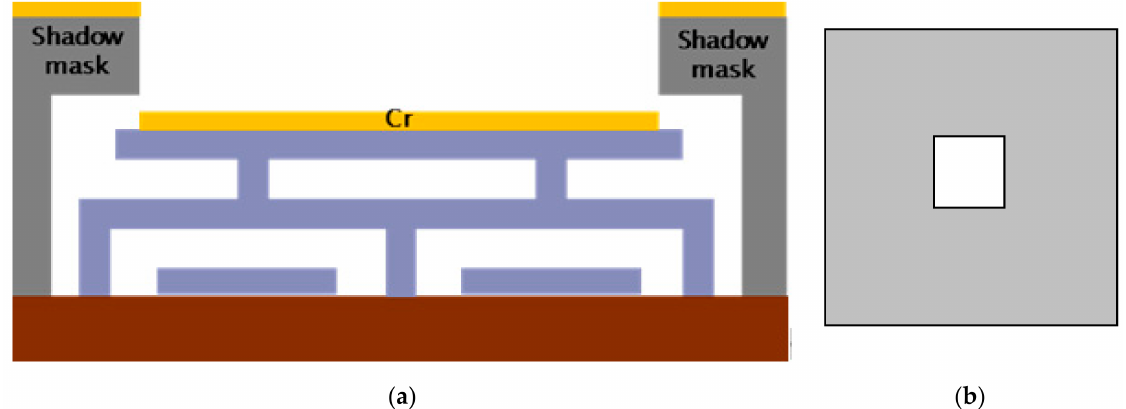
Figure 9. ( a ) A schematic of shadow masking technique. ( b ) Top view of the shadow mask.